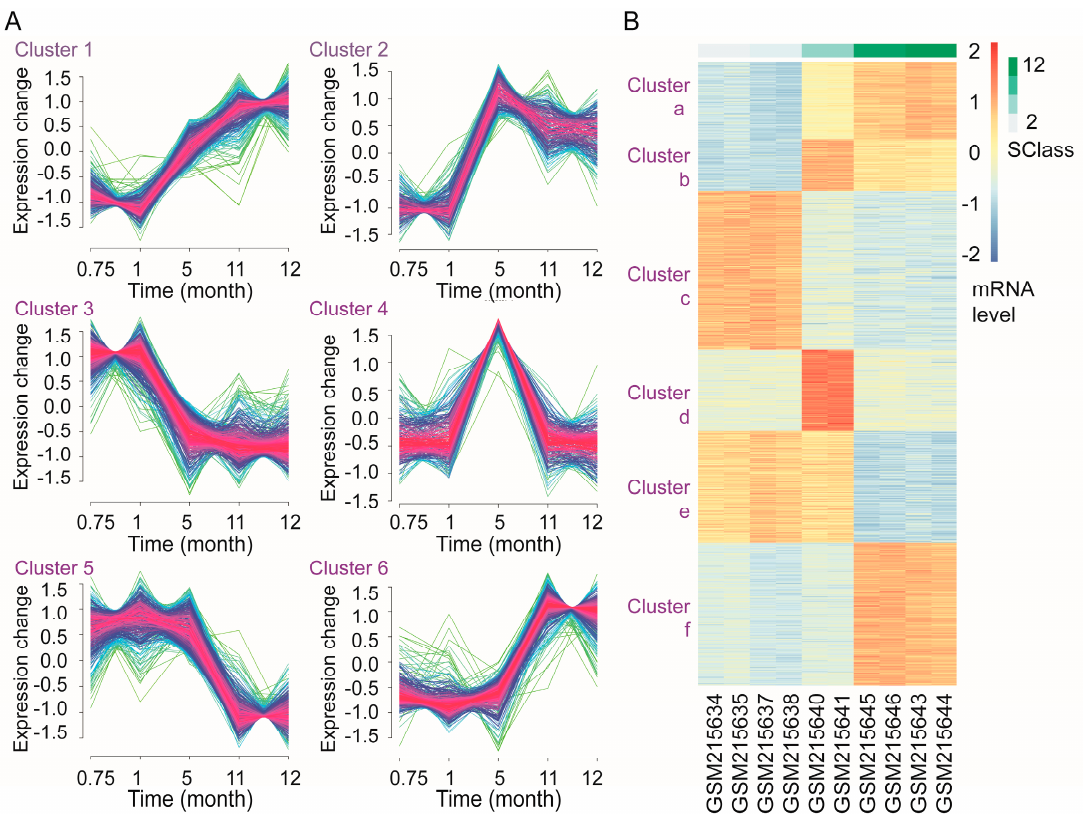
Figure 3. Clustering analyses of genes in LNCaP cells during androgen deprivation. ( A ) Clustering analysis based on Mfuzz software. Red: most close to the clustering center; blue: moderately close to the clustering center; green: least close to the clustering center; ( B ) Hierarchical clustering analysis based on pheatmap software and Mfuzz clusters. Blue: low messenger RNA (mRNA) level; red: high mRNA level. Scale bar represents the duration of androgen deprivation and pheatmap-clusters a, b, c, d, e, and f correspond to Mfuzz clusters 1, 2, 3, 4, 5, and 6, respectively.